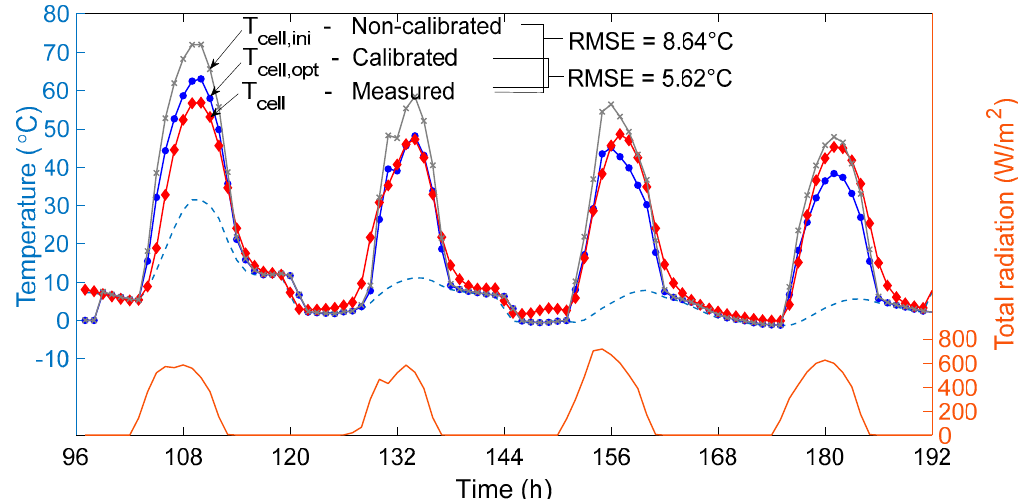
Figure 10. Temperature evaluation of calibrated and noncalibrated models for unused in situ test data (last four days).